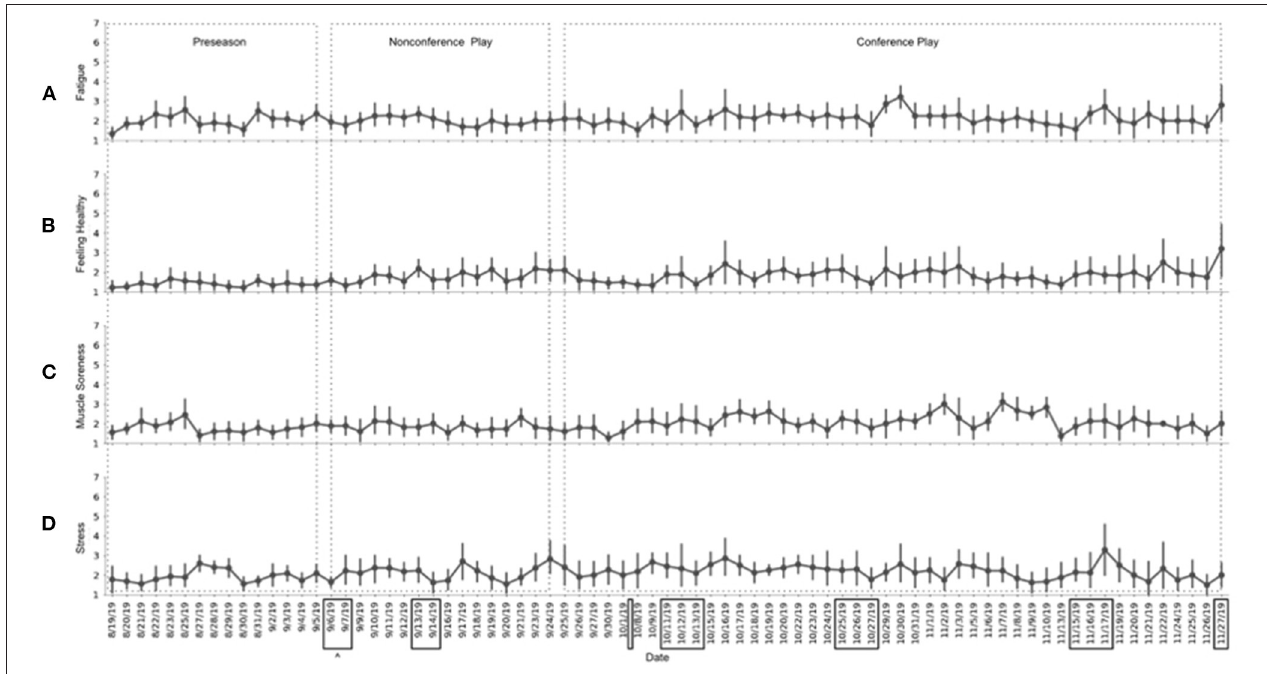
FIGURE 2 | Average team wellness scores over the season. (A) Perceived fatigue values over the season; (B) Perceived feelings of being healthy values over the season; (C) Perceived muscle soreness values over the season; (D) Perceived stress values over the season. Point estimates represent the team mean for the day and the error bars represent 95% CI. ∧ Boxes denote days of